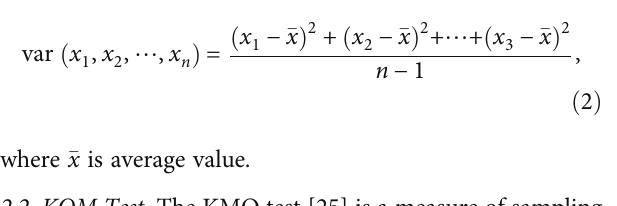
Table 1: Formal research sample